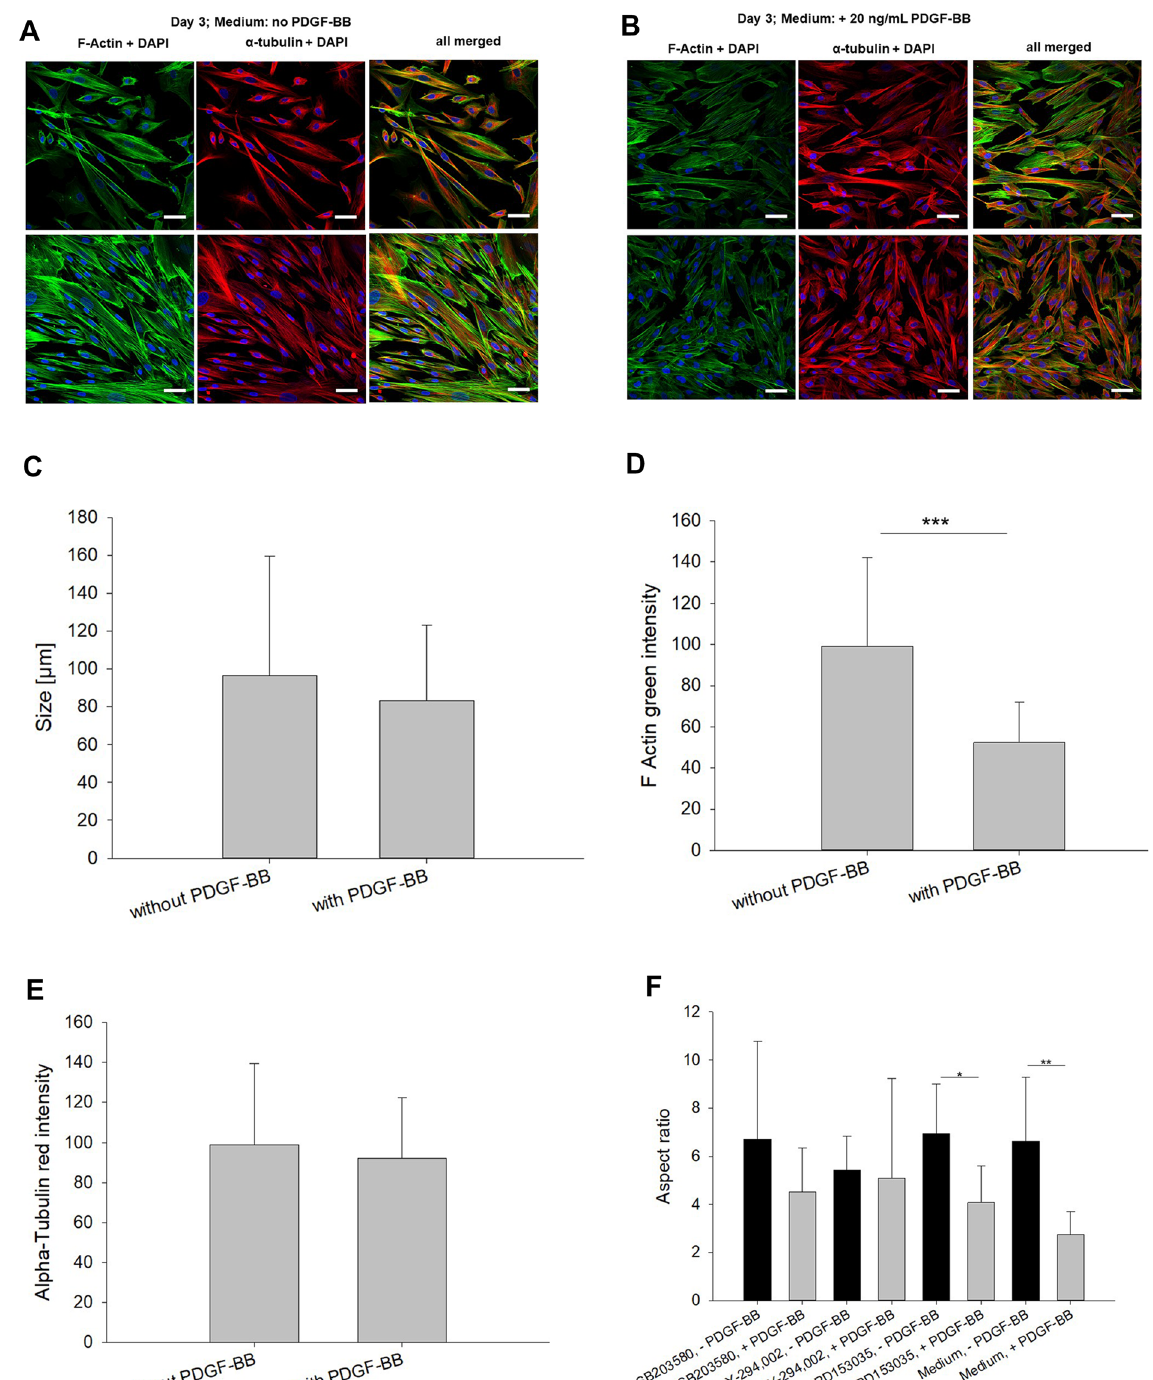
Figure 5. Images of tenocyte cultures without PDGF-BB ( A ) and with 20 ng/mL PDGF-BB ( B ) on day 3, showing F-actin (green), α-tubulin (red) and DAPI (blue, cell nuclei). PDGF-BB accompanying PAR-2 induction changes the F-actin cytoskeleton. Scale bars are equivalent to 50 µm. Achilles tenocytes of one rabbit are shown in the upper row, and of another rabbit in the lower row. Size of cells ( C ), F-actin green intensity ( D ) and α-tubulin red intensity ( E ), and aspect ratio of tenocytes on day 3 after addition of an inhibitor (40 µM, 5% FBS) with or without PDGF-BB ( F ). Key: SB203580 = inhibitor for MAPK; LY-294002 = inhibitor for PI3K; PD153035 = inhibitor for EGFR; DMSO = dimethyl sulfoxide (solvent of inhibitors); Medium = basal culture medium DMEM (with 10%